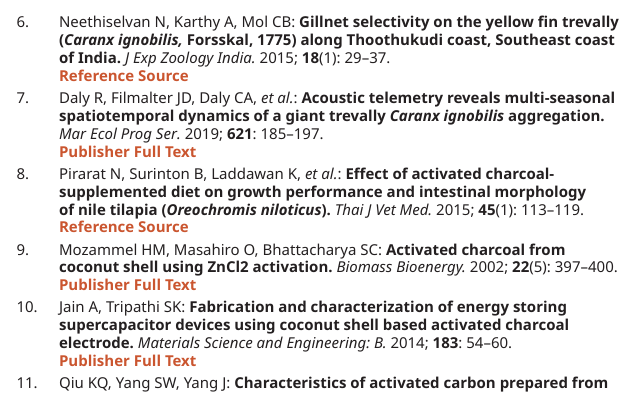
Figshare: Supplementation of rice husk activated charcoal in feed and its effects on growth and histology of the stomach and intestines from giant trevally Caranx ignobilis,